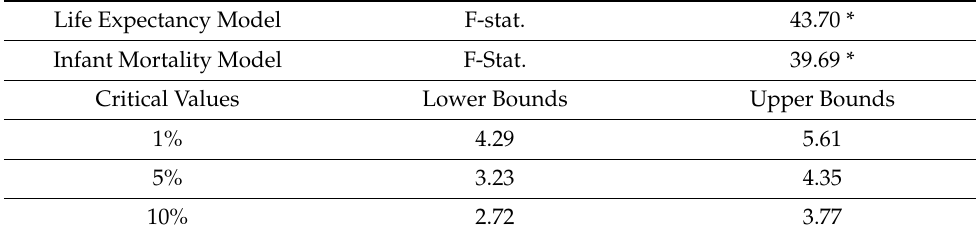
Table 7. Results of ARDL Bounds Test for Health Outcomes. Life Expectancy Model F-stat. 43.70 * Infant Mortality Model F-Stat. 39.69 * Critical Values Lower Bounds Upper